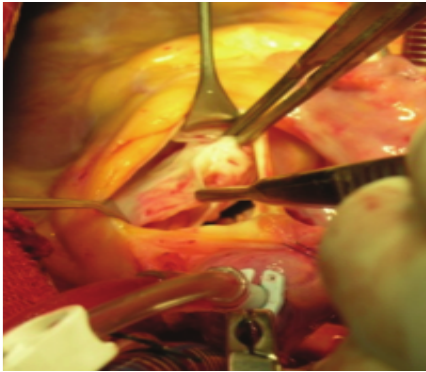
Figure 2: The aneurysm sac of the sinus of